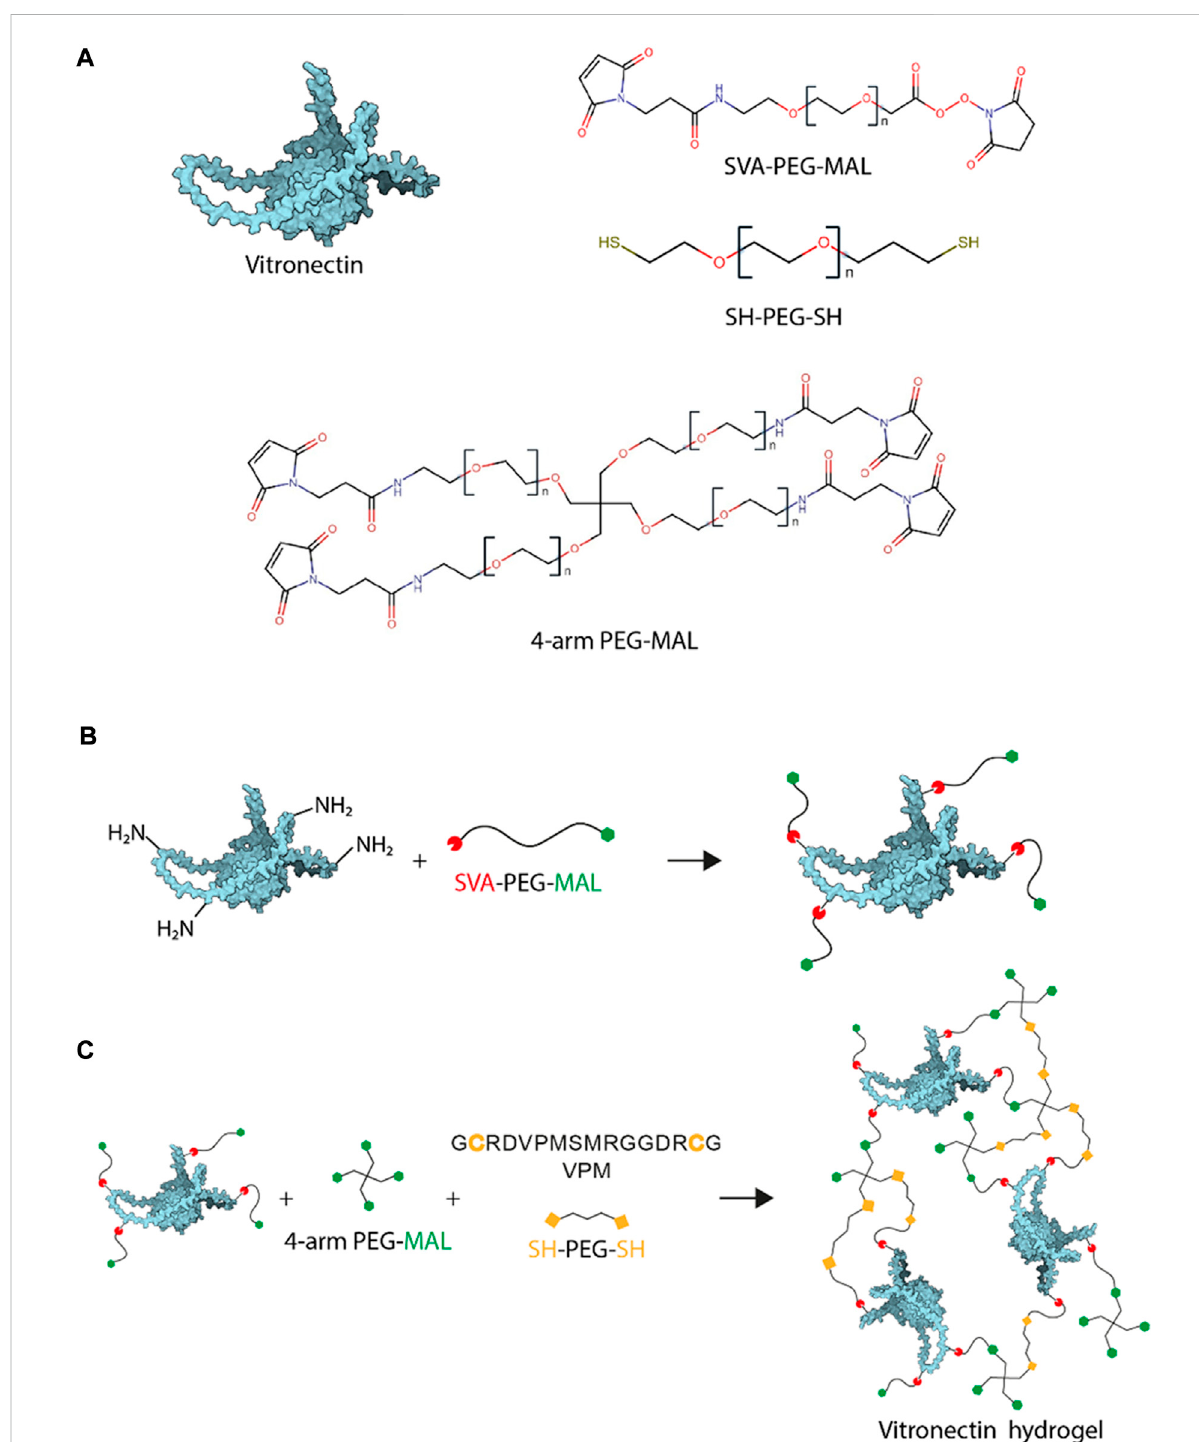
FIGURE 1 VN-based hydrogel chemistry. (A) . Gel components: vitronectin structure, SVA-PEG-MAL, SH-PEG-SH and 4-arm PEG-MAL. (B) . VN PEGylation is the reaction used to functionalise VN molecules with MALs at different ratios and (C) . VN/PEG gel formulation schematic drawing prepare using Michal type addition, reaction used to crosslink the MAL to